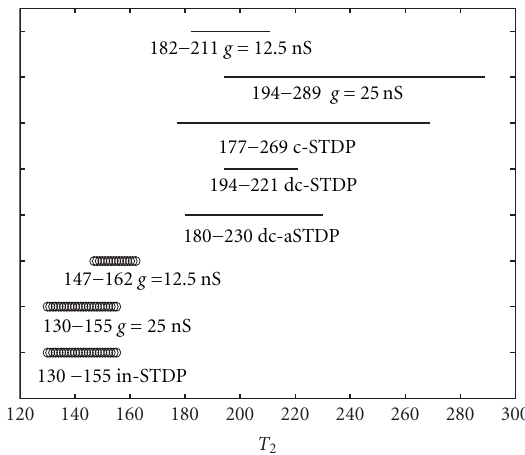
Figure 3: The synchronization window of di ff erent types of learning curves. The top five lines (points) are excitatory synapses and the bottom three lines (circles) are inhibitory synapses. See legends in the